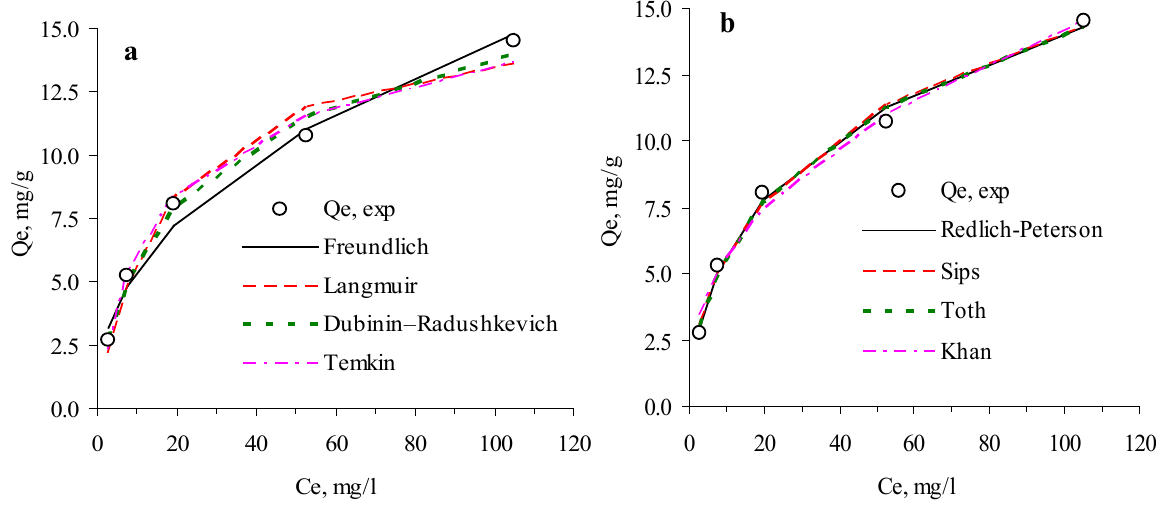
Figure 1. Comparison of adsorption isotherm models at 10 °C ; ( a ) two-parameter isotherms; ( b ) three-parameter